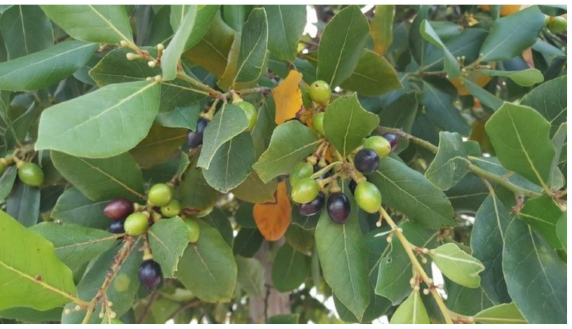
Figure 12. Laurus nobilis L.